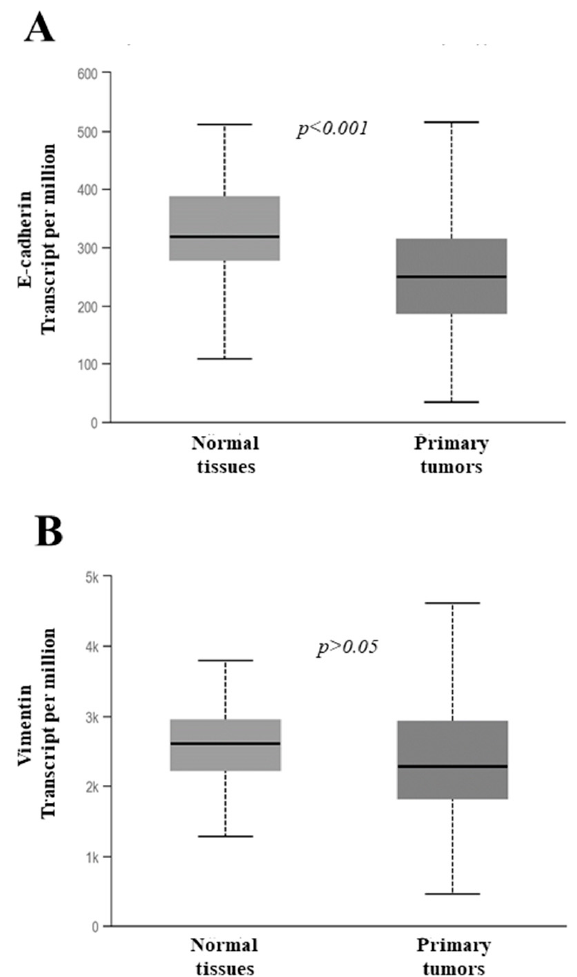
Figure 3. Expression level of the E-cadherin gene and vimentin from The Cancer Genome Atlas network case study consisting of 59 normal tissues and 505 PTC tissues. ( A , B ) The data are presented as a box plot reporting the median value (small bar) and the first (lower box limit) and third (upper box limit) quartiles and the range of the values observed for each gene.